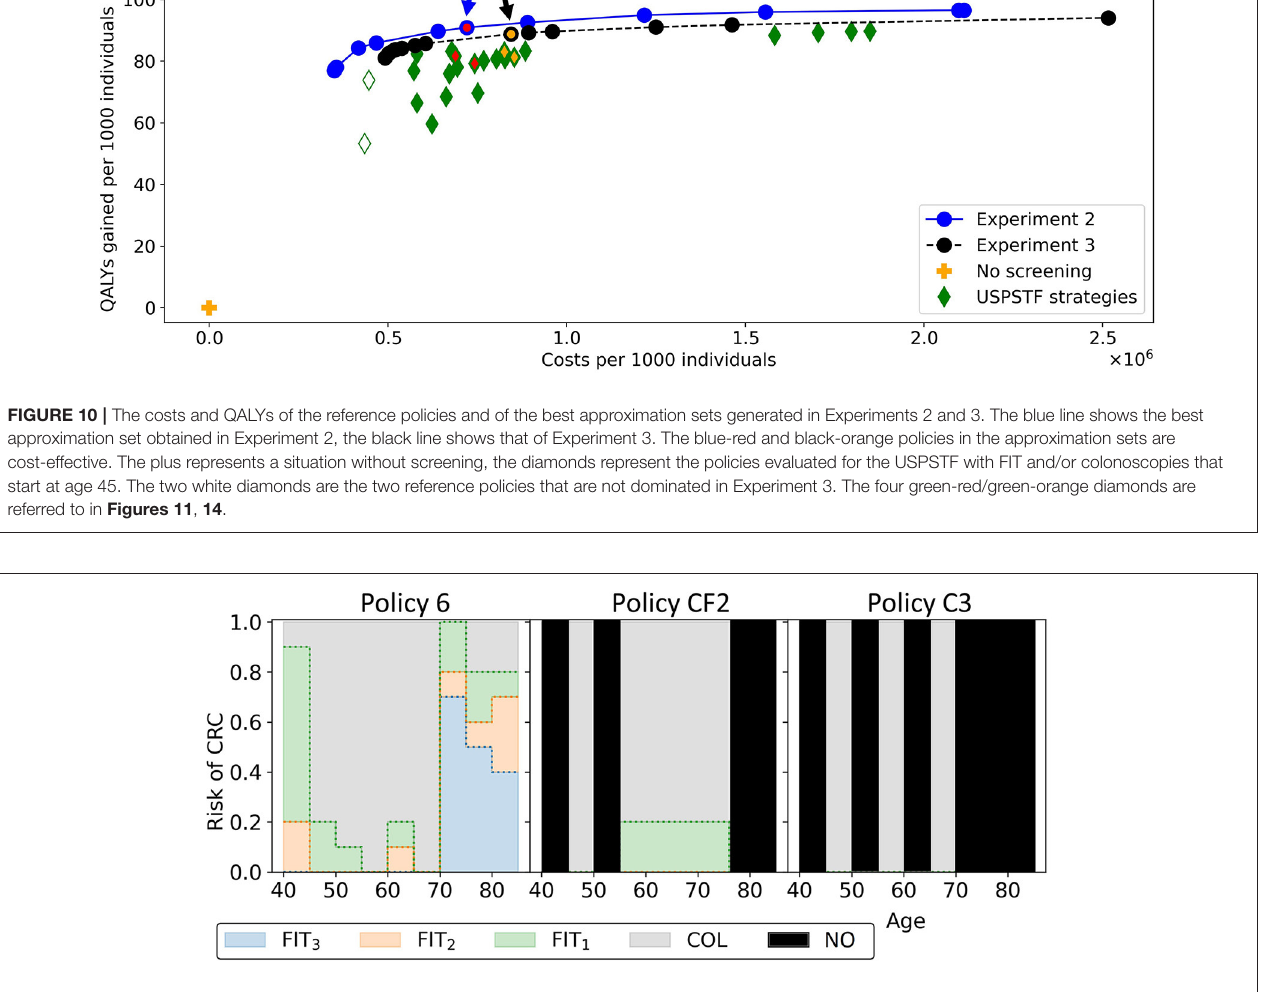
FIGURE 11 | The three blue-red/green-red policies in Figure 10 are shown. Policy 6 is the cost-effective policy within the willingness-to-pay threshold in the approximation set for Experiment 2. Policies CF2 and C3 are the closest reference policies in terms of costs and QALYs (these policies are listed in Supplementary Table 3 ). For age groups with a black bar, reference policies do not offer